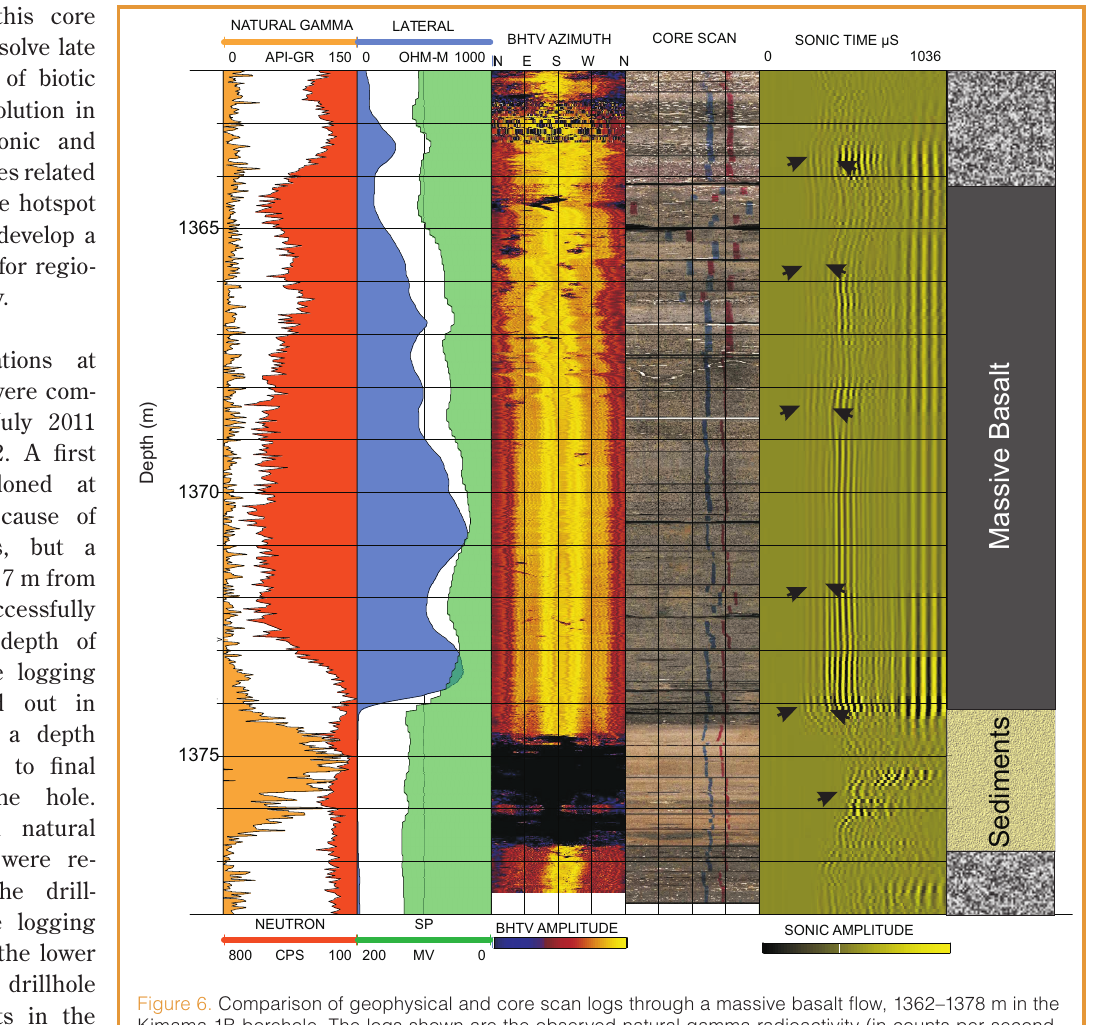
Figure 6. Comparison of geophysical and core scan logs through a massive basalt flow, 1362–1378 m in the Kimama 1B borehole. The logs shown are the observed natural gamma radioactivity (in counts per second, CPS), the returning scattered neutron response (in reversed counts per second), the lateral electrical resistivity log (linear scale in Ω–m), and the Spontaneous Potential (SP) log (in reversed mV). The borehole televiewer (BHTV) amplitudes are normalized, and black indicates lost signal; the BHTV log has been rotated to align with geographic north. The unwrapped core scans are from RGB images; these have not been oriented. In the sonic log display the arrivals of the P- and S-waves are highlighted by right and left pointing arrows,